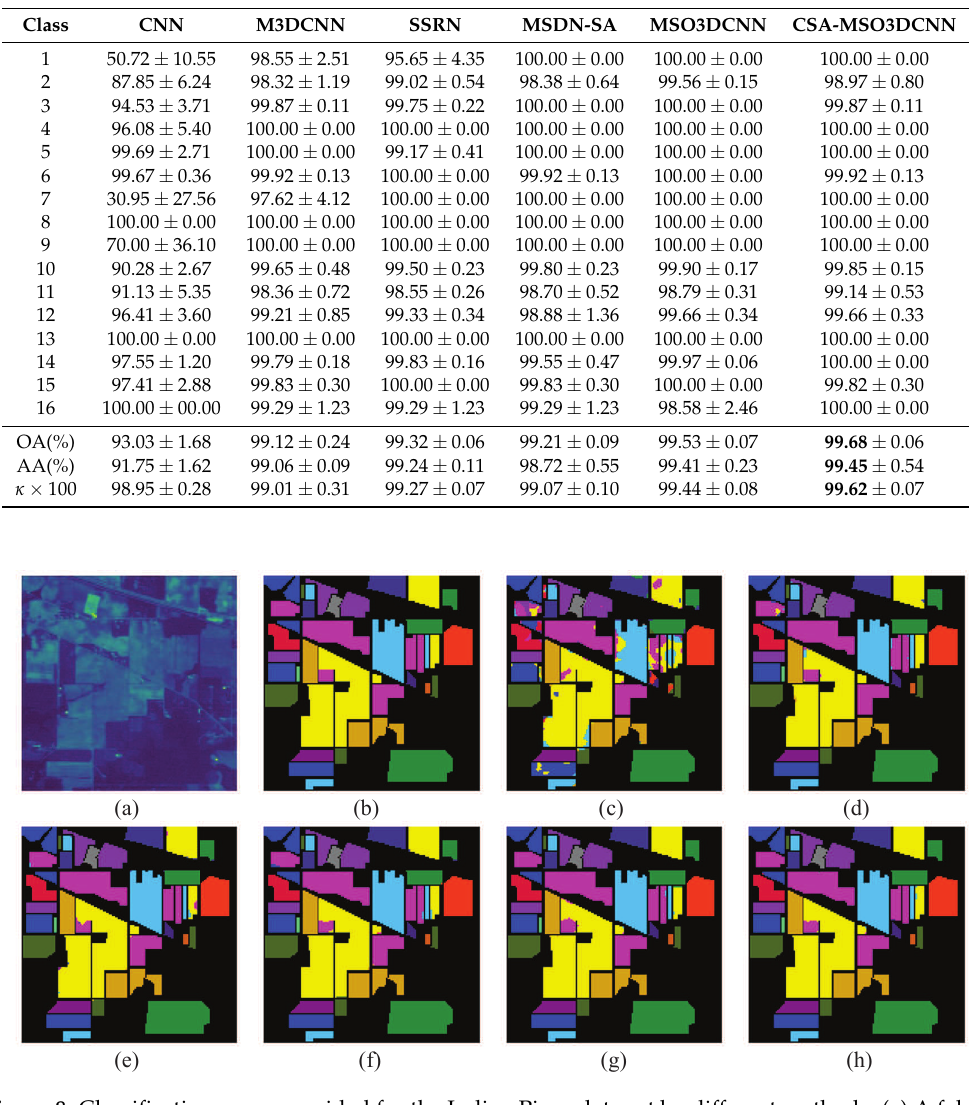
Figure 8. Classification maps provided for the Indian Pines data set by different methods. ( a ) A false color map. ( b ) The ground truth map. ( c ) CNN (93.03%). ( d ) M3DCNN (99.12%). ( e ) SSRN (99.32%). ( f ) MSDN-SA (99.21%). ( g ) MSO3DCNN (99.53%). ( h ) CSA-MSO3DCNN